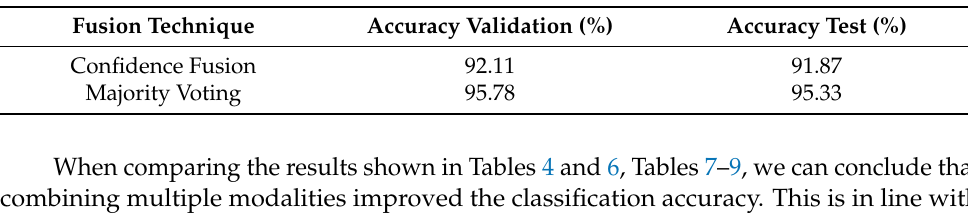
Table 9. Results of multimodal prediction of trust using combinations of three